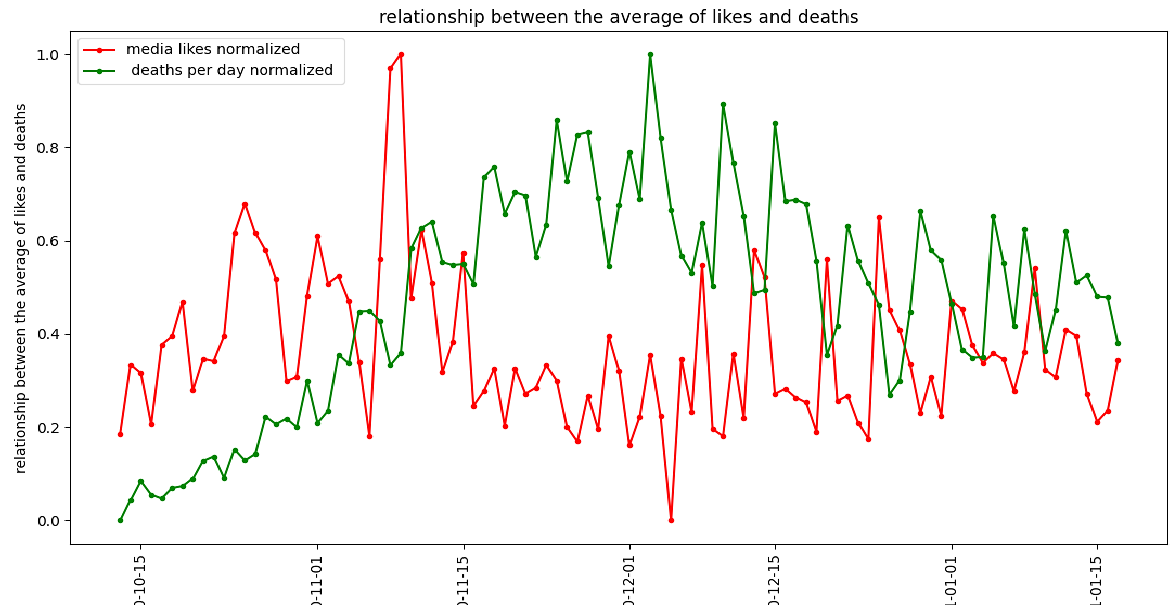
Figure 11. Average likes and number of deaths